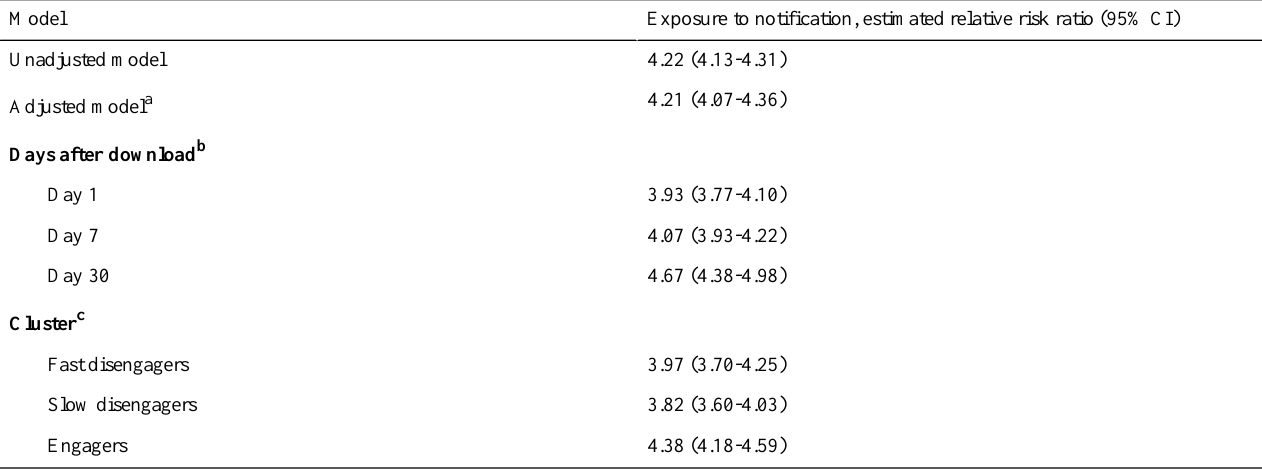
Table 3. Estimated associations between exposure to the notification and app use.